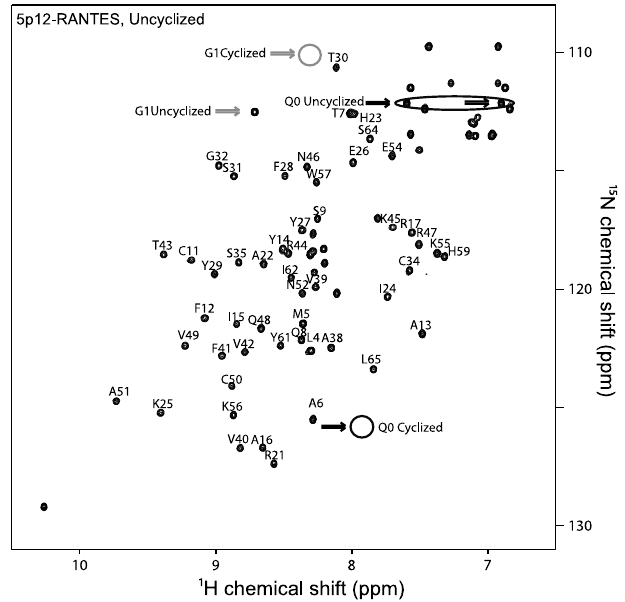
Figure 2. Heteronuclear single quantum coherence (HSQC) nuclear magnetic resonance (NMR) spectrum of 15 N-labeled 5P12-RANTES directly after dissolution in pH 2.8 20 mM sodium phosphate buffer at 25 °C. Little or no cyclization is observed at this time. Cyclization of Q0 results in a shift of the G1 peak (labeled, grey arrows; cyclized position circled) which can be used to quantify the amount of cyclized 5P12-RANTES in solution. Cyclization also results in loss of Q0 side chain amide peaks (black arrows, circled) and appearance of cyclized Q0 lactam peak (black arrow, circle). Chemical shift assignments from Wiktor et al. [28]; no assignments are shown for region near E66, where these authors used a variant. Also not shown are side chain assignments for W57 and Asn/Gln (except for the relevant N-terminal side chain amide). Percent cyclization was determined by peak height at lower contour level than shown.